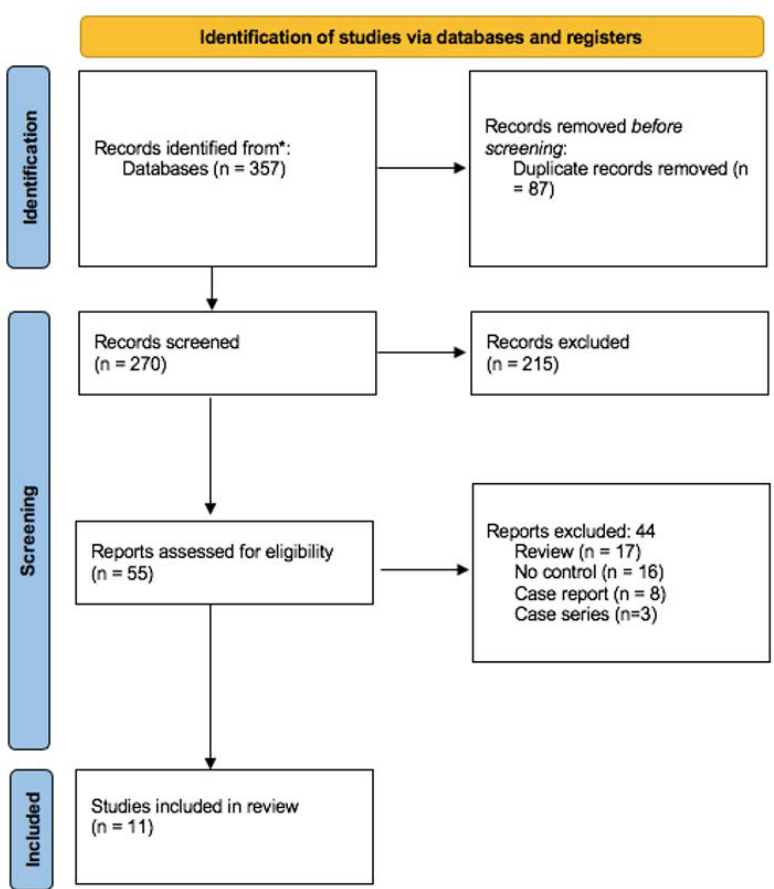
Figure 1. Flow diagram of the selection of the studies (performed according to the PRISMA guidelines). Table 1. Features of included randomized controlled